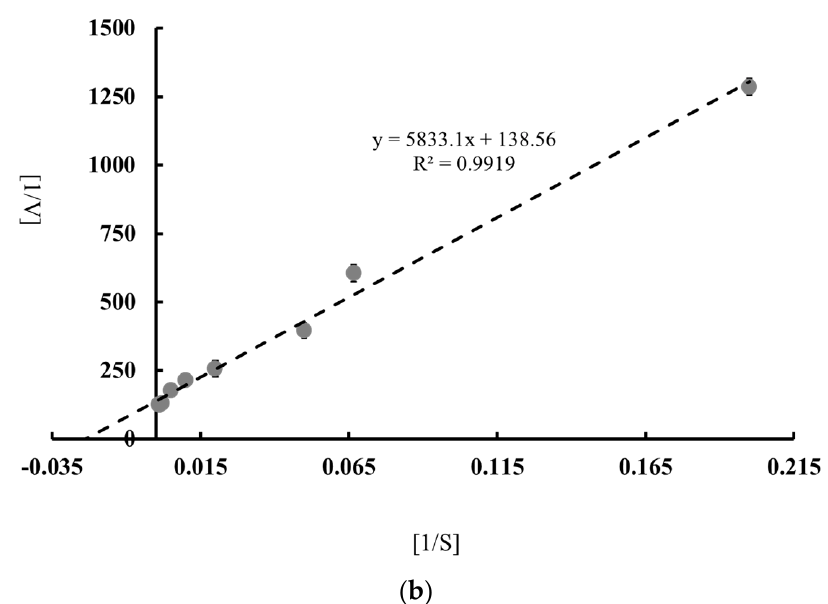
Figure 4. ( a ) Michaelis–Menten curve and ( b ) Lineweaver–Burk double reciprocal plot of MD2-SBro. Table 3. Kinetic parameters of MD2-SBro in comparison to MD2-MBro.